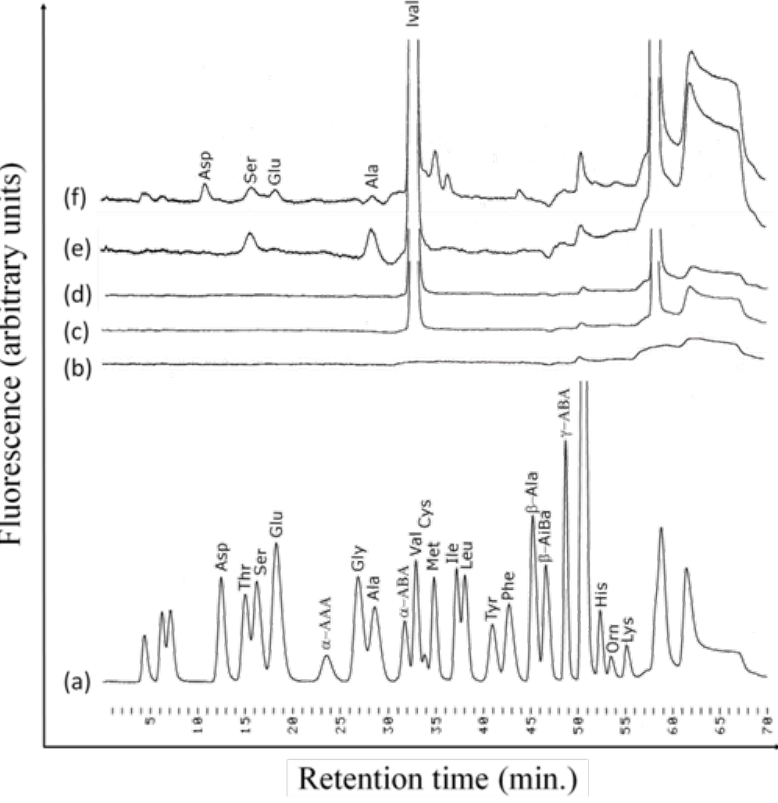
Figure 4. Ion exchange chromatograms of amino acids: ( a ) Wako amino acid standard, ( b ) Blank (milli-Q water), ( c ) Ival without UV irradiation, ( d ) Ival without γ-ray irradiation, ( e ) UV (continuous) irradiated (7.6 J) Ival and ( f ) γ-ray irradiated (40 J) Ival. Abbreviations: Asp: Aspartic acid, Thr: Threonine, Ser: Serine, Glu: Glutamic acid, α-AAA: α-Aminoadipic acid, Gly: Glycine, Ala: Alanine, α-ABA: α-Aminobutyric acid, Val: Valine, Cys: Cystine, Met: Methionine, Ile: Isoleucine, Leu: Leucine, Tyr: Tyrosine, Phe: Phenylalanine, β-ala: β-Alanine, β-AiBa: β-Aminoisobutyric acid, γ-ABA: γ-Aminobutyric acid, His: